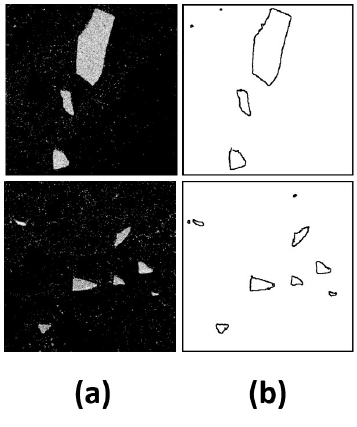
Figure 9. (a) SAR images of the areas referred to the Sector III in the map of Figure 6. (b) Edge detection result of applying the Adaptive Canny